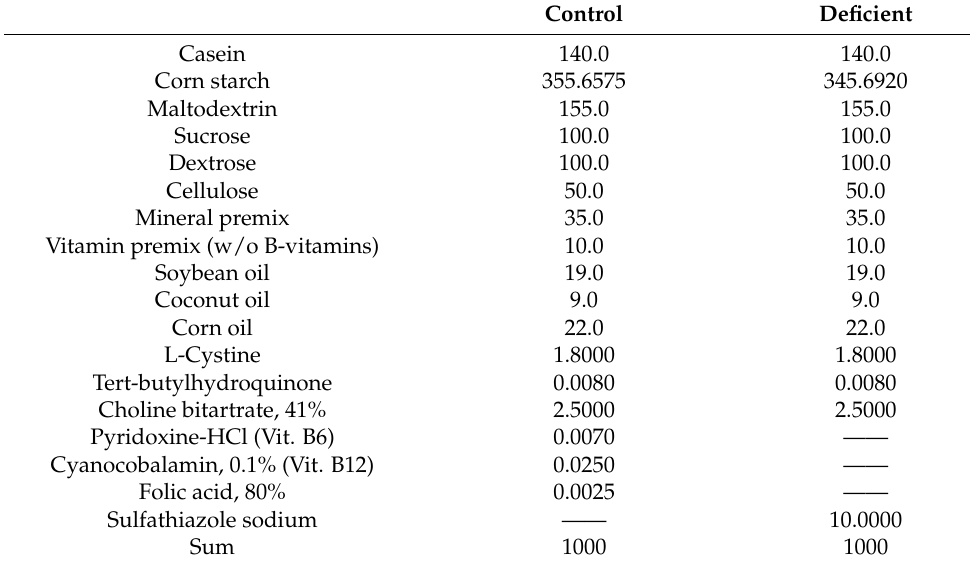
Table 2. Exact composition of the control (normal) diet and the B-vitamin deficient